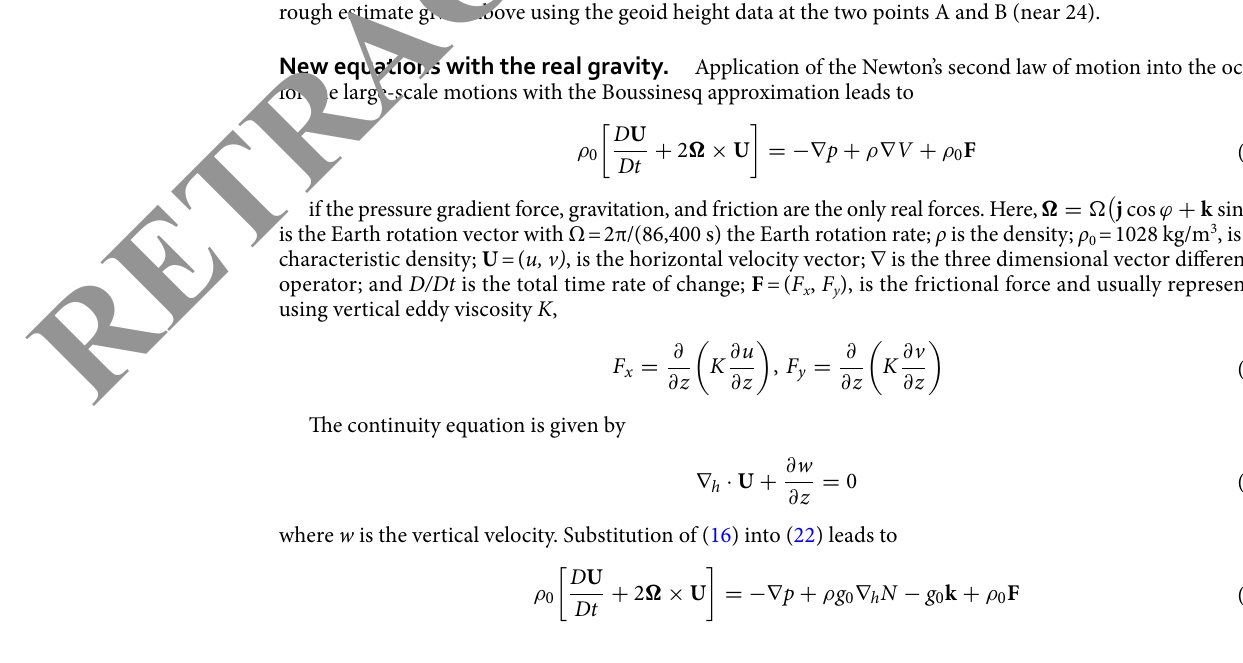
Figure 4. ( a ) The world ocean surface (z = 0) distribution of (1/ C ), and ( b ) histogram of (1/ C ). The source codes for the plots were written by the author ‘s research group using the Matlab Version R2019b (https:// www. mathw orks. com/ produ cts/ matlab.